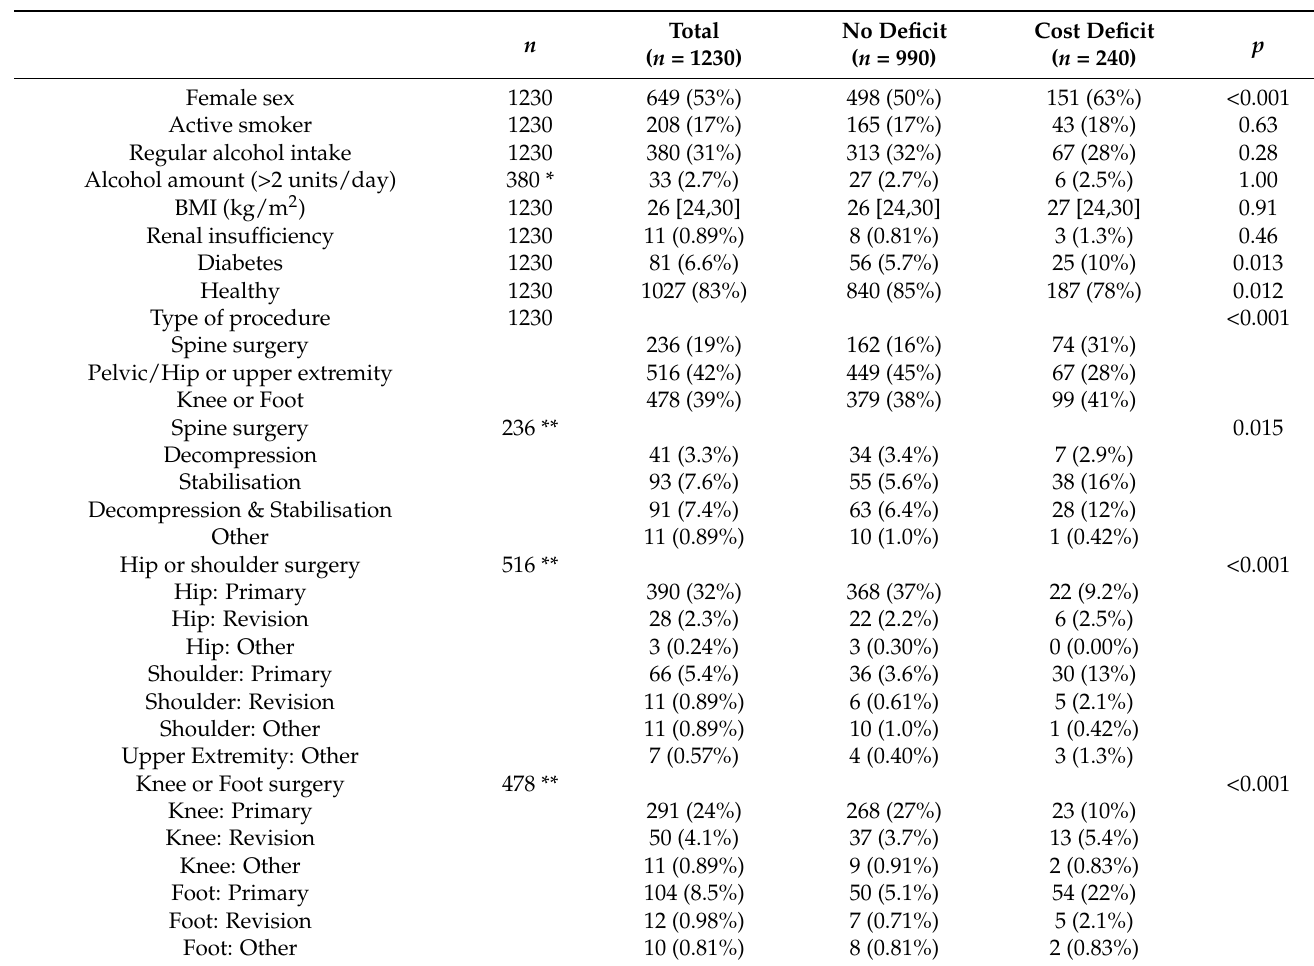
Table 1. Patient characteristics and surgical sub-types. Patients were divided into two groups: If net financial results were positive, the patient was allocated to the “no deficit” group. If net financial results were negative, the patient was allocated to the “cost deficit” group. p -value refers to the difference between the “no deficit” and the “cost deficit”